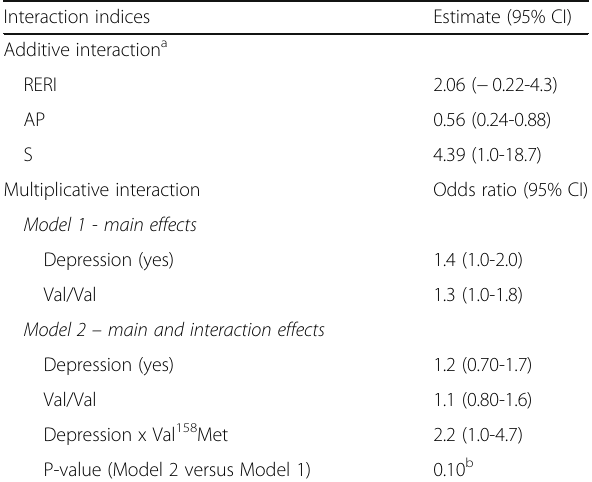
Table 4 Additive and multiplicative interaction analyses between COMT Val 158 Met and depression for